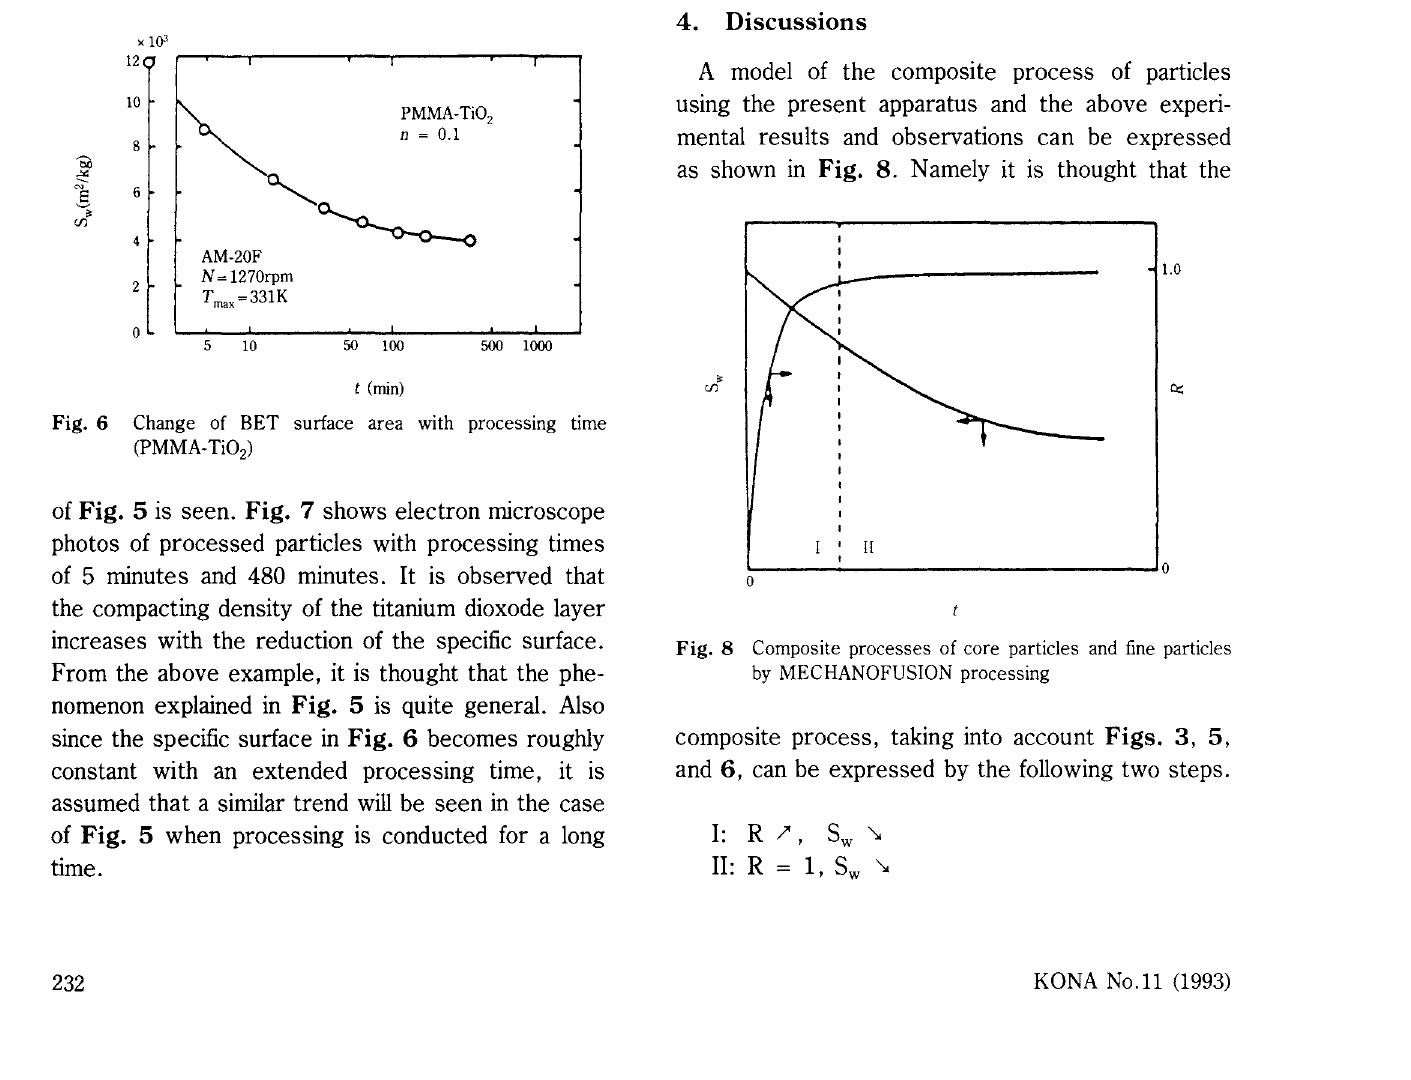
Fig. 7 Electron microscope pictures of PMMA-Ti0 2 composite particles, (a) (b): 5 min process, (c) (d): 480 min pro cess, (a) (c): SEM, (b) (d): TEM pictures of section areas, x 10,000